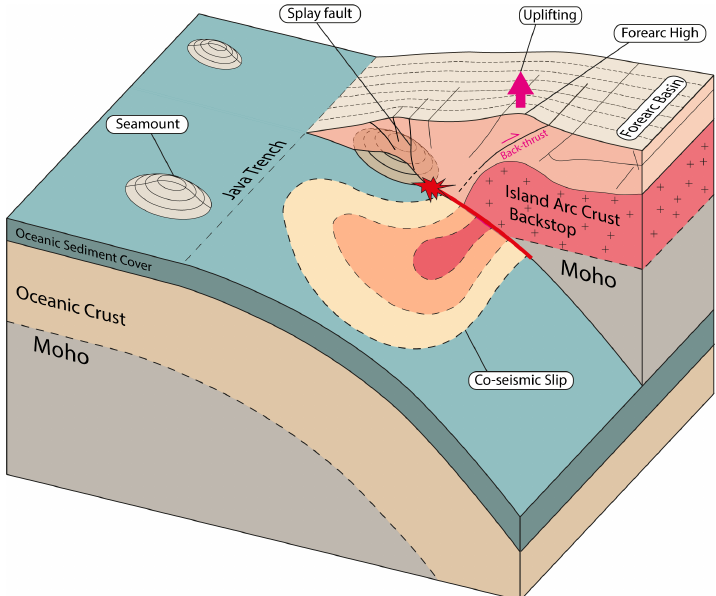
Figure 5. Conceptual seismo-tectonic model of the eastern Java margin in the region of the 1994 tsunami earthquake. Back-thrusting above the island arc crust backstop causes locally enhanced uplift of the forearc high. The 1994 hypocentre (red star) originated at the leading edge of a subducting seamount. The seamount stalled the co-seismic slip propagation locally along the plate